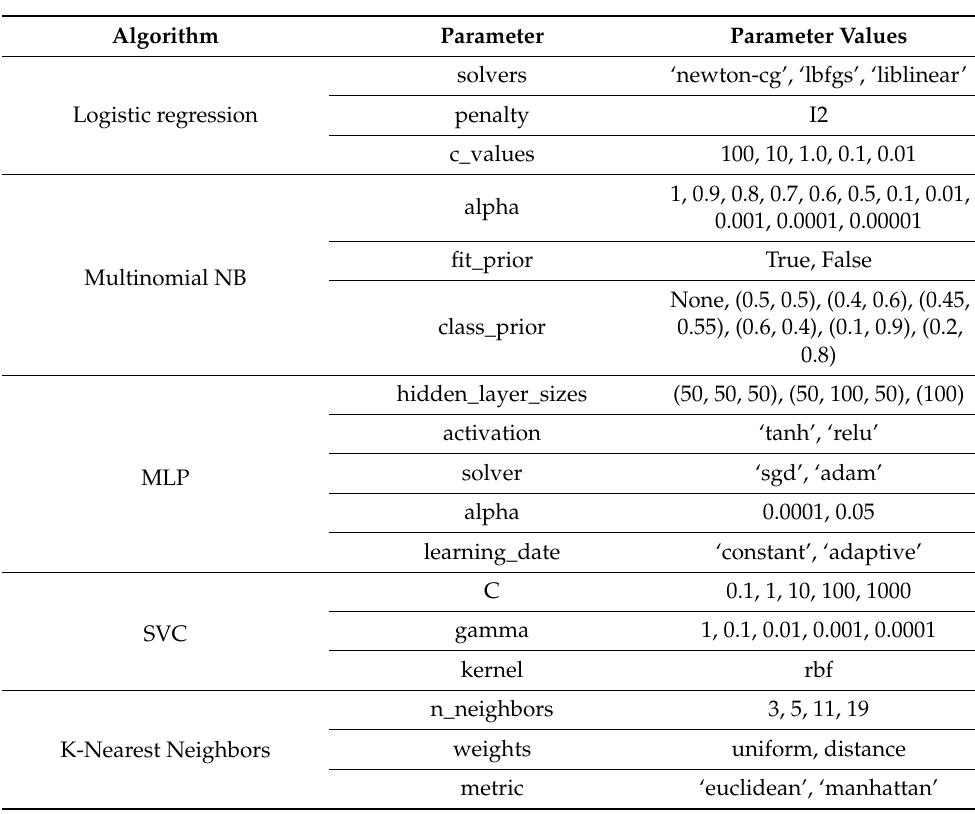
Table A3. The parameters and their values used in the hyperparameter tuning